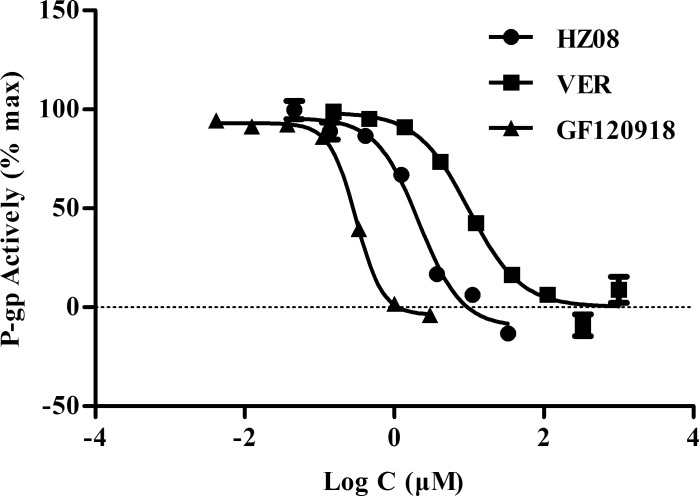
P-gp activity (% max) of VER, GF120918 and HZ08 detected by calcein-AM assay.Each point represents the mean±SD for triplated independent determinations.